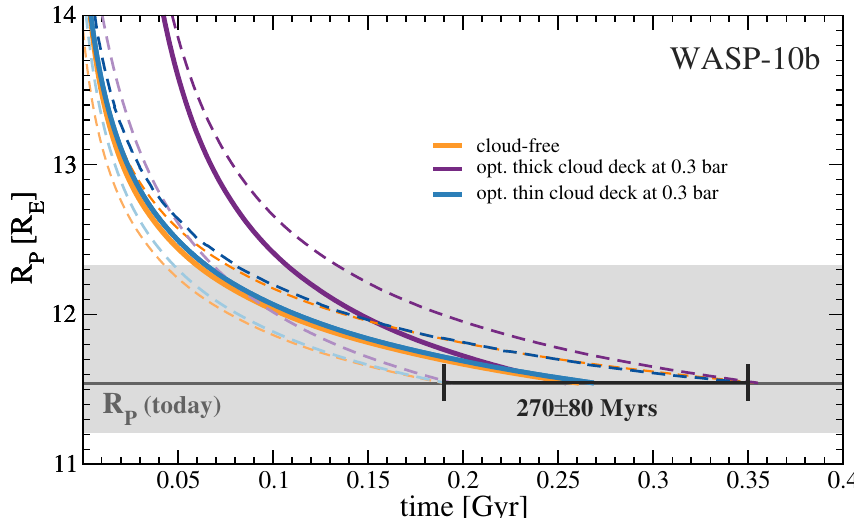
Figure 7. Radius evolution of WASP-10b for the cloud-free atmosphere (orange) as well as for optical thick (purple) and optical thin (blue) clouds decks at P c = 0.3 bar. Solid lines yield a cooling time of 270 Myr while dashed lines within the 1 σ uncertainty of the age, e.g., light dashed lines then describe models reaching the lower limit of the age constraint of 190